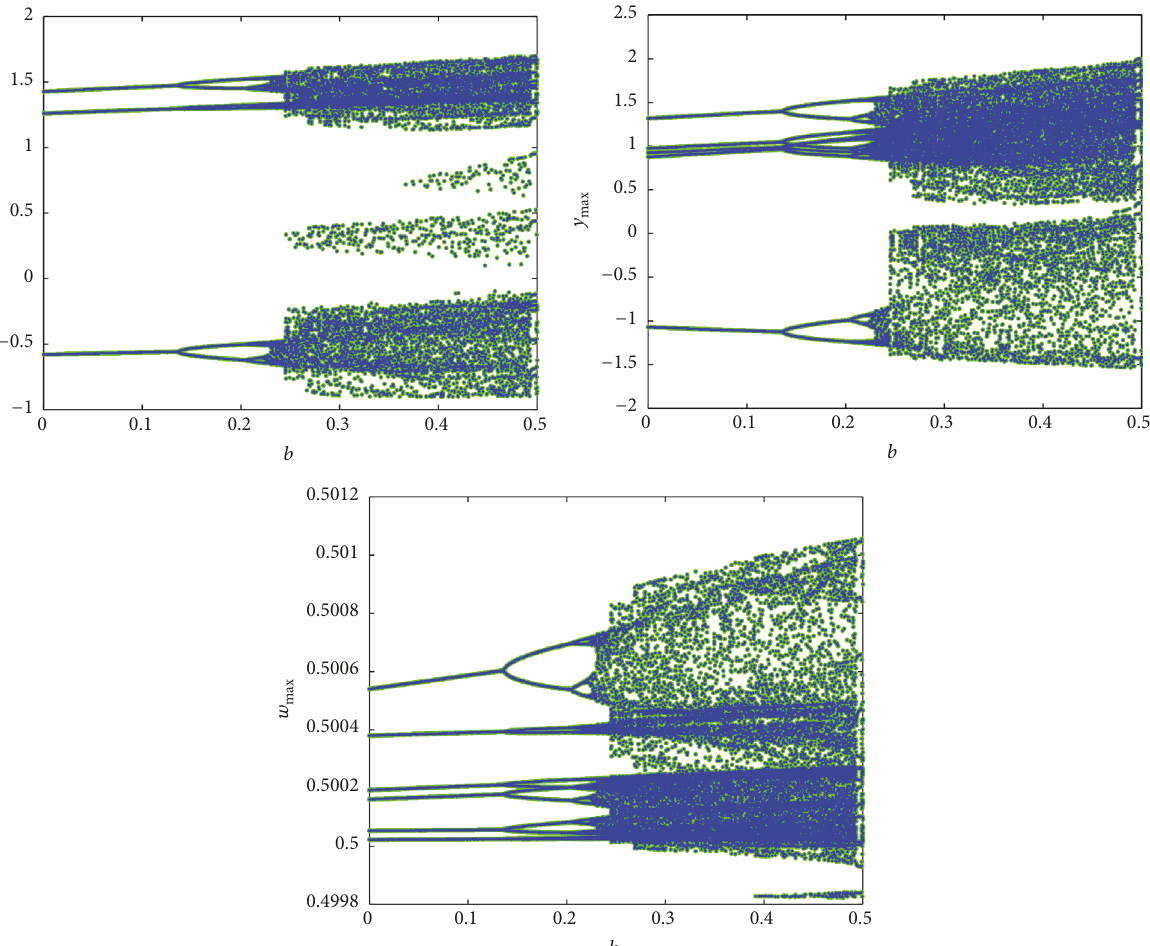
Figure 5: Bifurcation plots of FOPF system for 𝑏